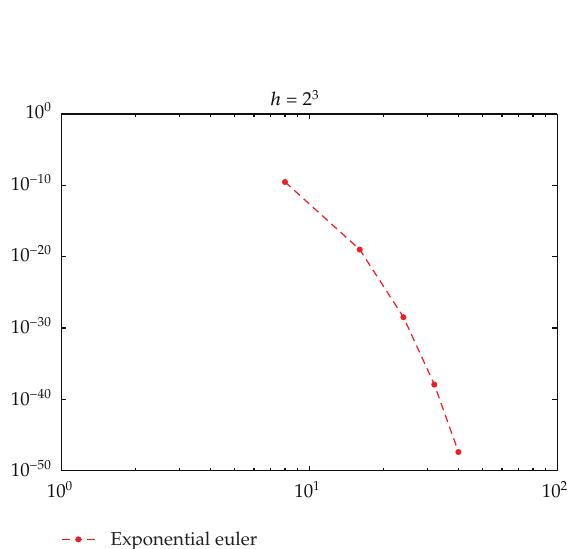
Figure 5: EM method.